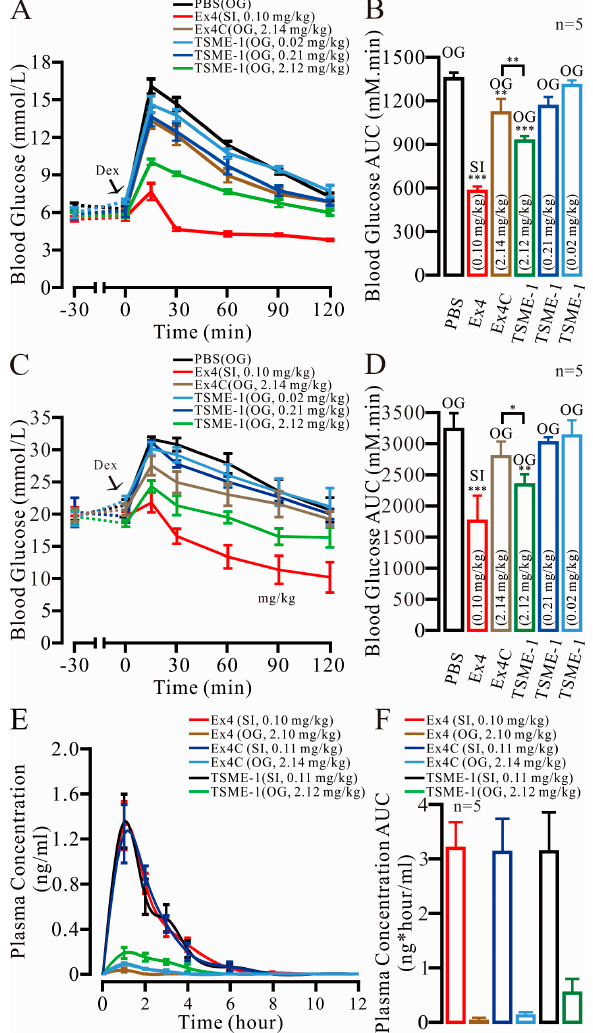
Figure 4. TSME-1 regulation of the blood glucose levels of normal and type 2 diabetes (T2D) mice was apparent in intraperitoneal glucose tolerance tests. ( A ) The BGL of the IPGTT for normal C57BL/6J mice; ( B ) The area under the curve (AUC) of the IPGTT for normal mice; ( C ) The blood glucose level (BGL) of the IPGTT for STZ/HFD-induced T2D mice; ( D ) The AUC of the BGL for T2D mice; ( E ) The plasma concentration of Ex4C and TSME-1 administrated by SI and OG were measured in 12-hour respectively; ( F ) The AUC of drug concentration in plasma. The data are presented as the mean ± SEM, n = 5, * p < 0.05, ** p < 0.01, *** p < 0.001.